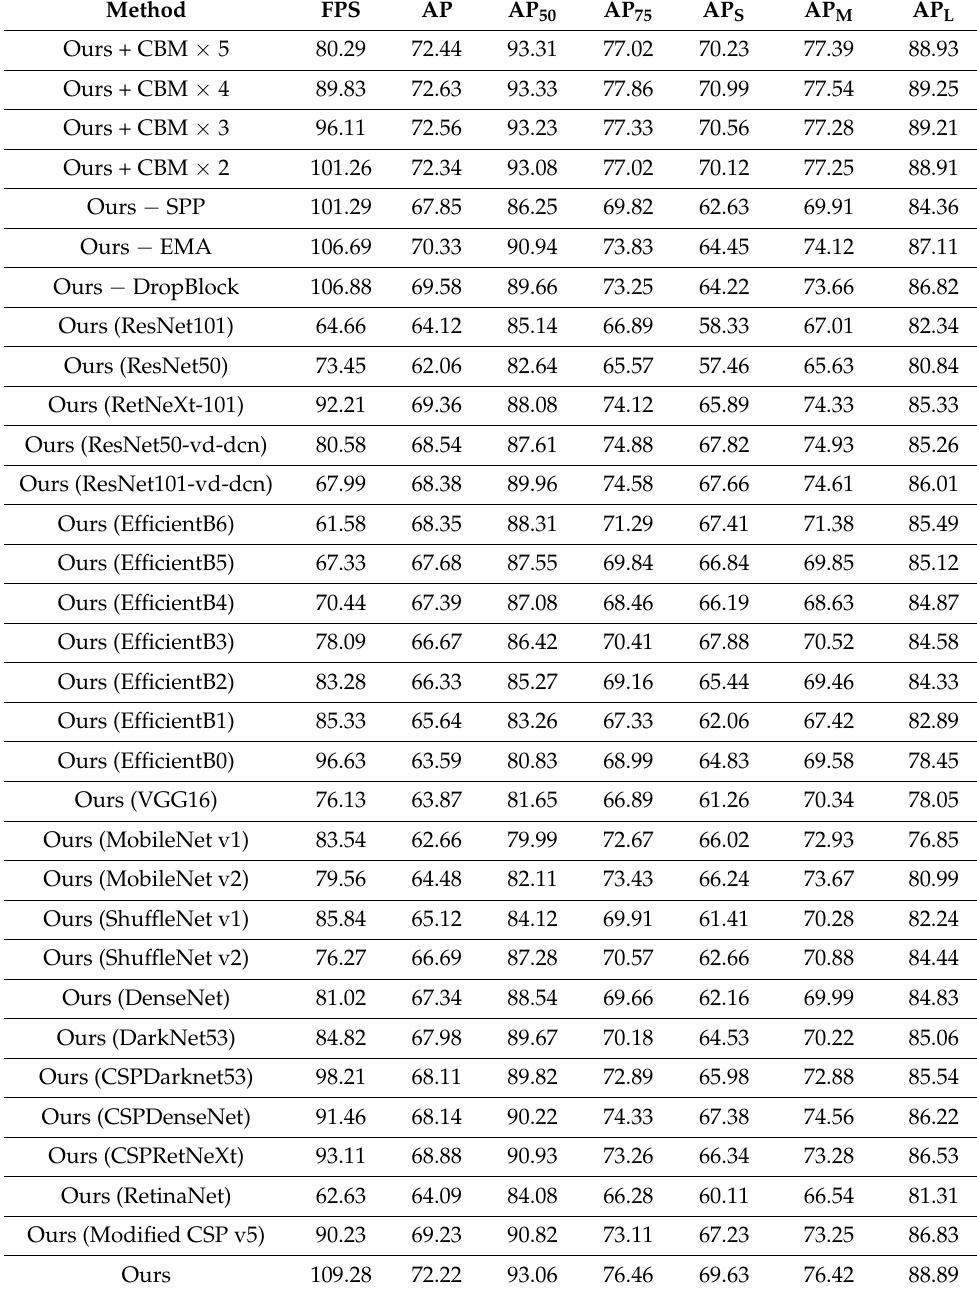
Table 3. The ablation experiment results of different